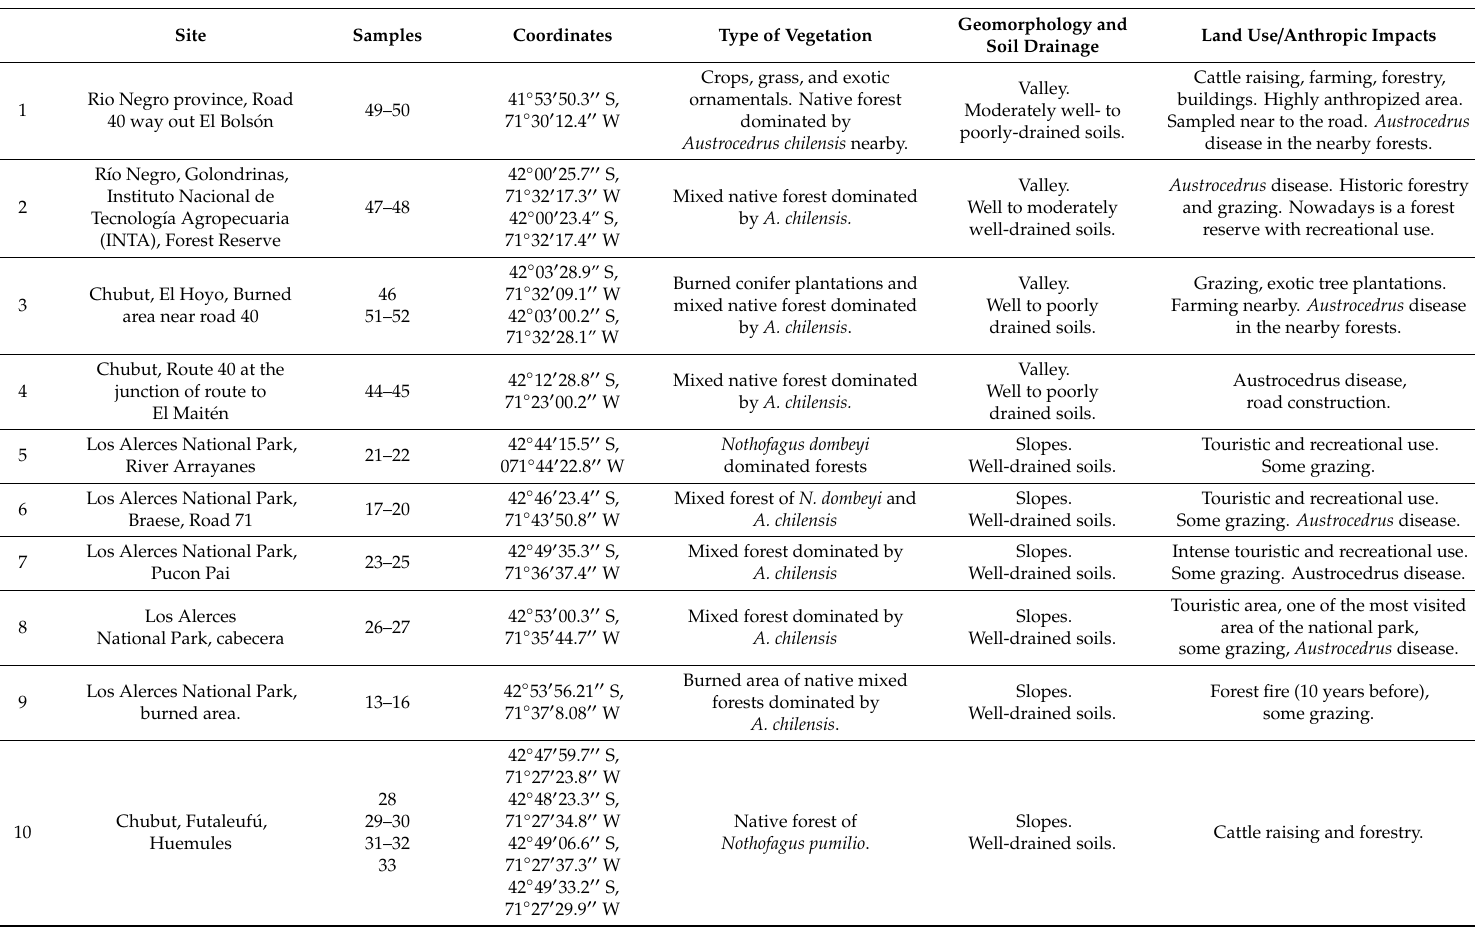
Table 1. Description of sampling sites: localization and descriptions of the vegetation, geomorphology, and land